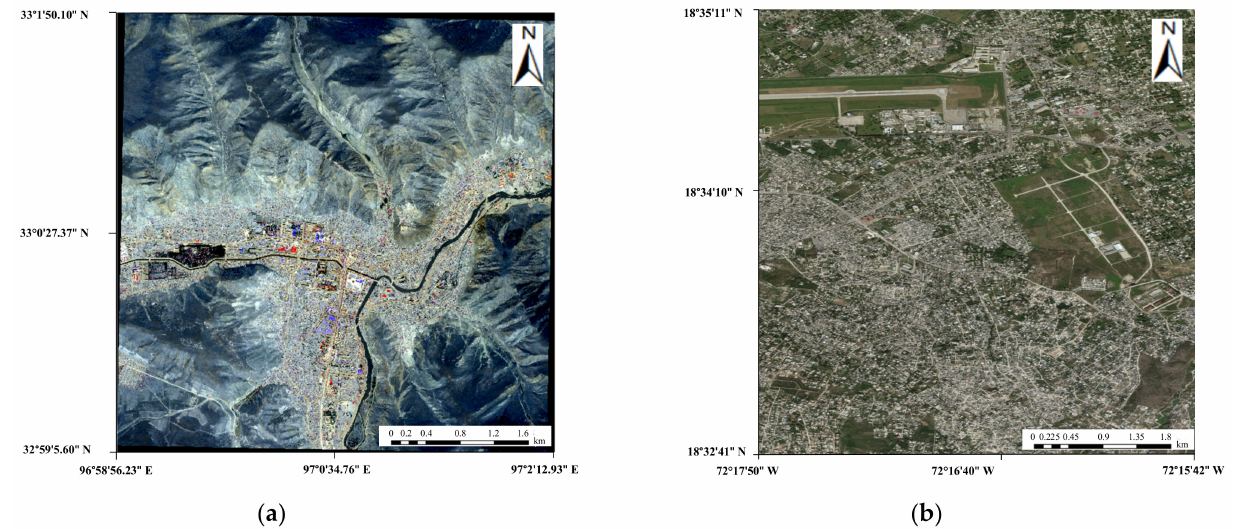
Figure 7. The post-earthquake VHR remote sensing images in the research regions. ( a ) YSH dataset. ( b ) HTI